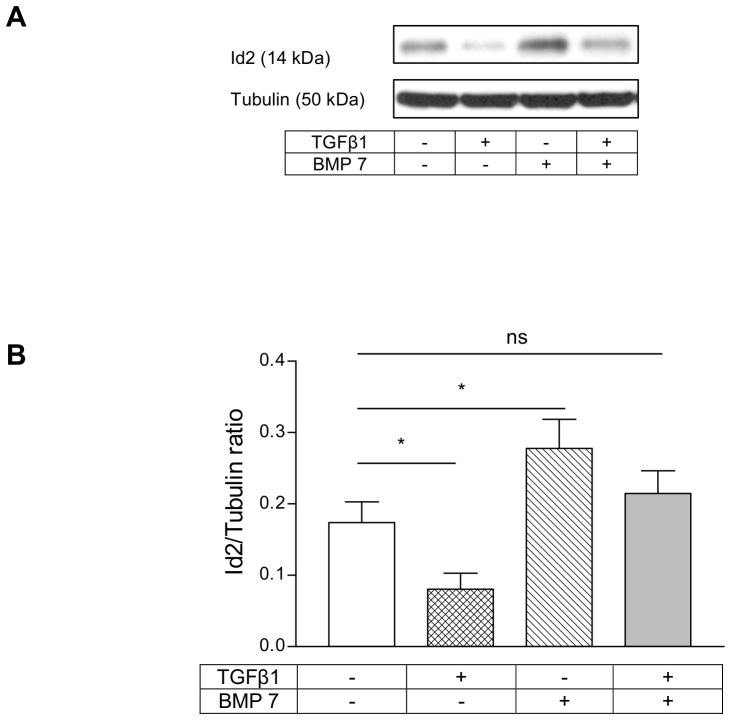
Id2 was counter-regulated by TGFβ1 and BMP 7 in HKC 8 cells.HKC 8 cells were treated with either vehicle (0.1% BSA), TGFβ1 (5 ng/ml), BMP 7 (200 ng/ml) or both for 24 h and the expression of Id2 was determined by immunoblotting. The representative immunoblot shows the expression of Id2. TGFβ1 downregulated Id2 levels on the other hand BMP 7 upregulated Id2 levels and combined treatment of BMP 7 prevented TGFβ1 induced Id2 loss. The data is expressed as mean±SD (n = 3, ns = P>0.05, *<0.05).